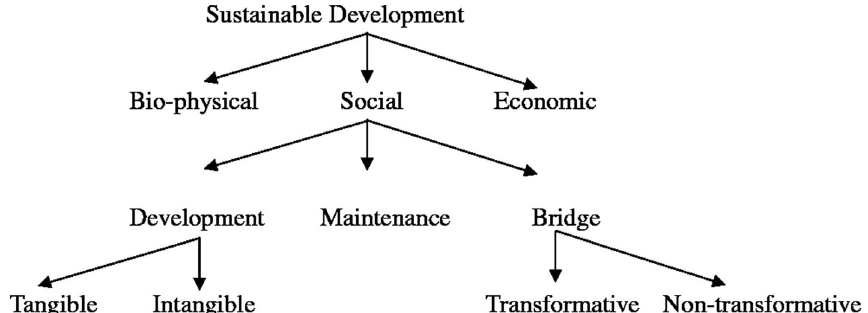
Fig. 6 Three strands of social sustainability. (Source: Vallance et al. 2011; Redrawn by the author